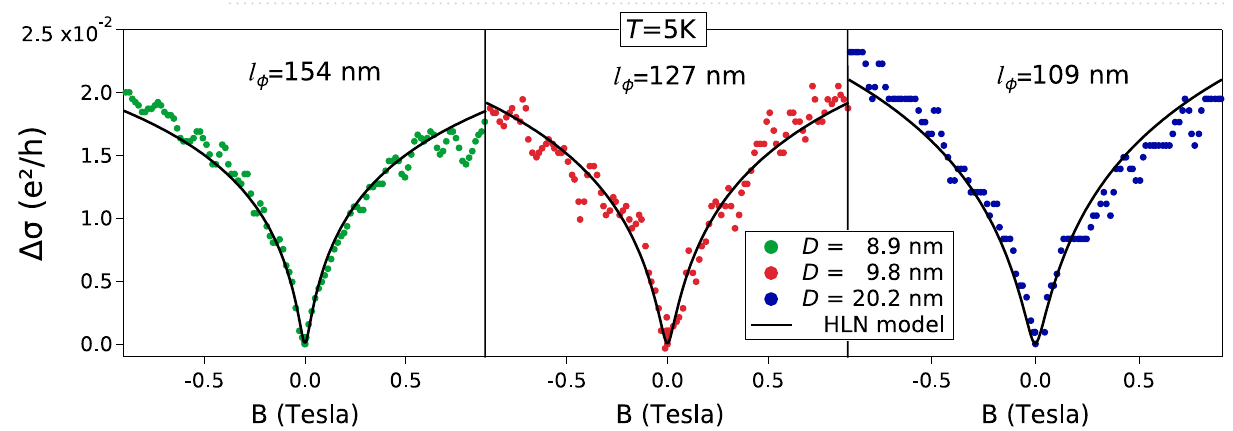
Figure 8. Temperature dependence of the normalized Hall constant for different samples measured at different temperatures, computed from R H = ρµ H .